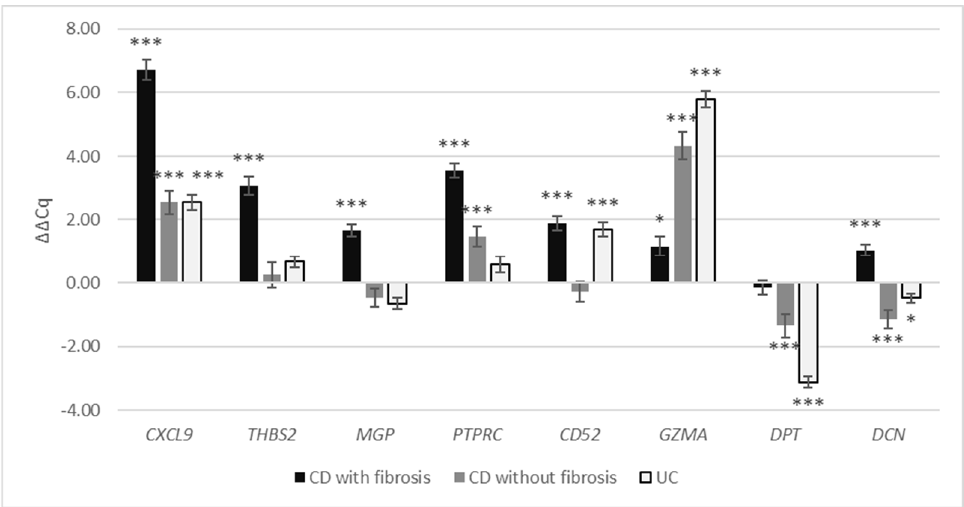
Figure 3. Gene expression of CXCL9 , THBS2 , MGP , PTPRC , CD52 , GZMA , DPT and DCN in colonic